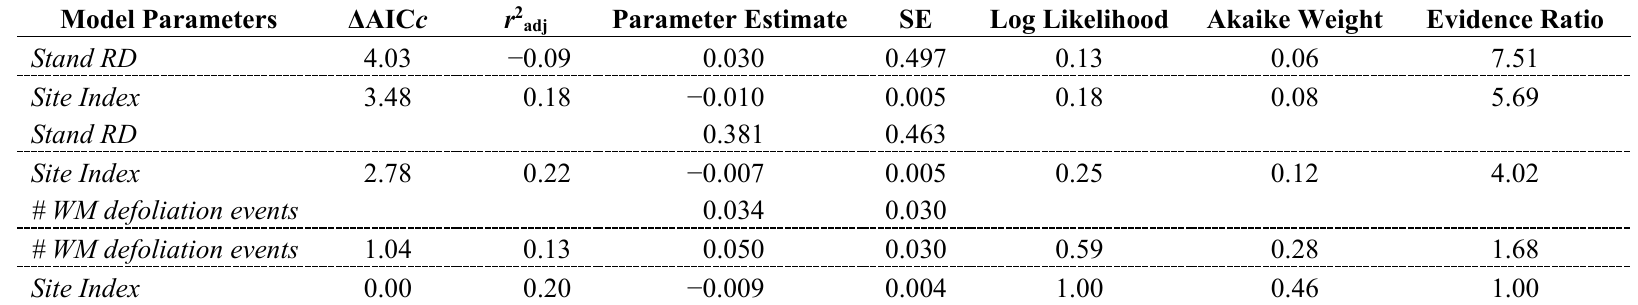
Table 4. Results of multiple regression on Percent of Quercus Basal Area in Dead Stems at 13 sites in eastern Massachusetts; ΔAIC c = corrected Akaike Information Criterion differences; SE = standard error.